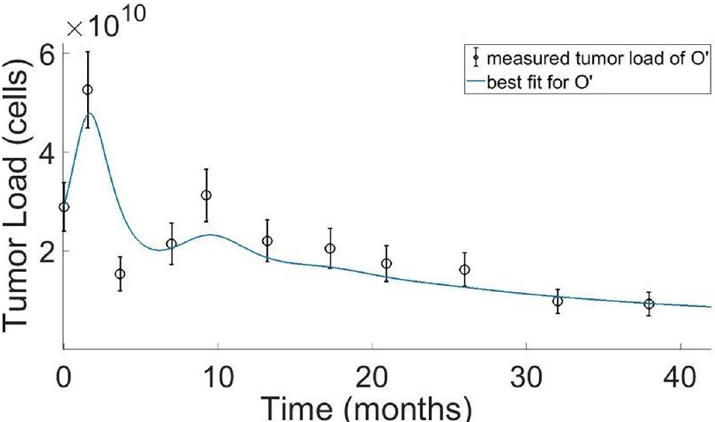
Fig 2. Model fit to clinical data. Clinical tumor load measured by PET/CT, derived from the clinical lesions data of an advanced melanoma patient from a hospital cohort (Patient O’), treated by pembrolizumab, 120 mg, every 3 weeks (empty circles). The data error bars were obtained assuming identical errors in measurements along all axes and given a maximal error of 3 millimeters for a standard CT measurement in each axis. The simulated time course of tumor load shows the best-fit to the clinically measured tumor load (curve). Model parameters of Patient O’, evaluated from the best-fit simulation curve are: p C = 1.828 h − 1 , k 0 = 0.00603 h − 1 , ρ = 0.95 h − 1 , k 03 = 0.0058 h − 1 , k 04 = 0.00535 h − 1 ,a SCM E C C = 0.05, a CM = 0.9,a EM = 0.03, and a EFF = 0.92. For other model parameters see the Materials and Methods section and the Supporting Information